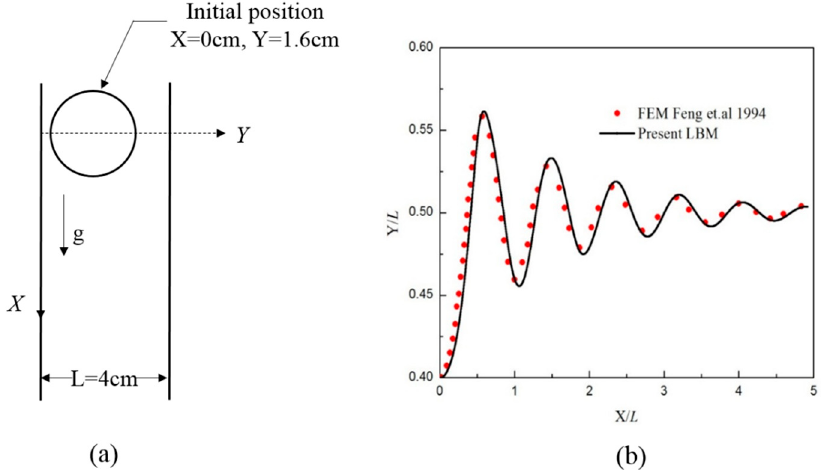
Figure 2. The benchmark case of single particle sedimentation. ( a ) The geometry of the simulation; ( b ) the comparison of particle trajectories. ( b ) the comparison of particle